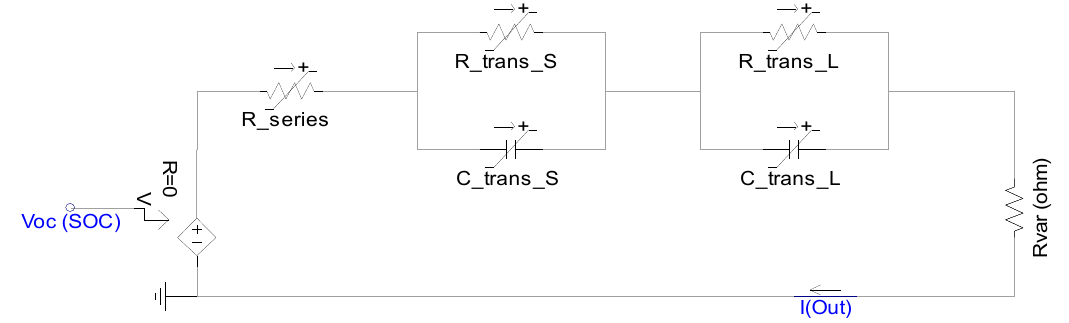
Figure 6. I ‐ V characteristics of the battery as a function of SOC.